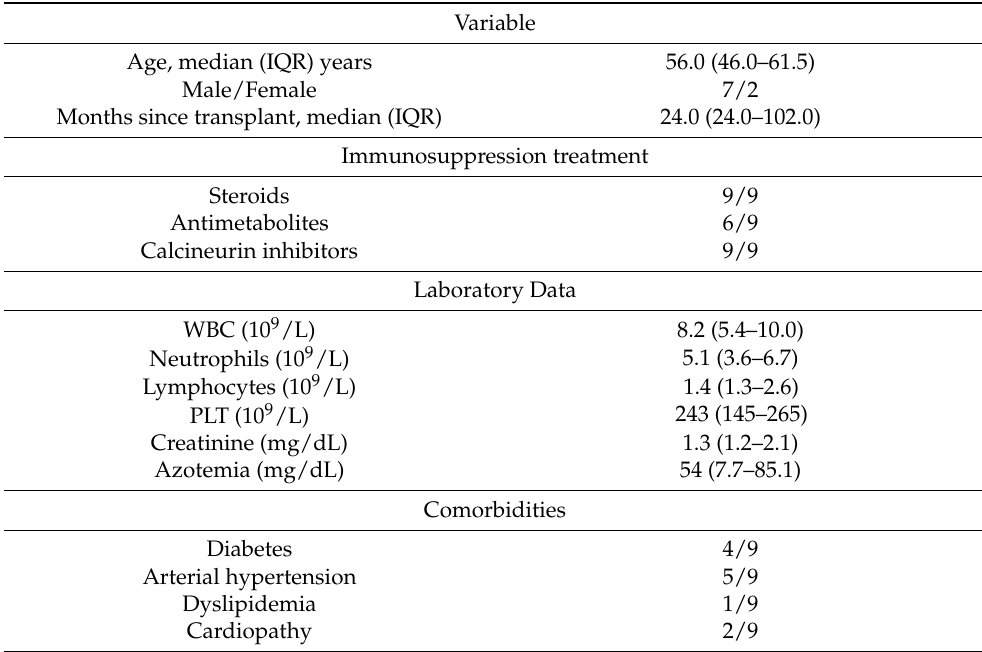
Table 1. Baseline characteristics of the enrolled LuT